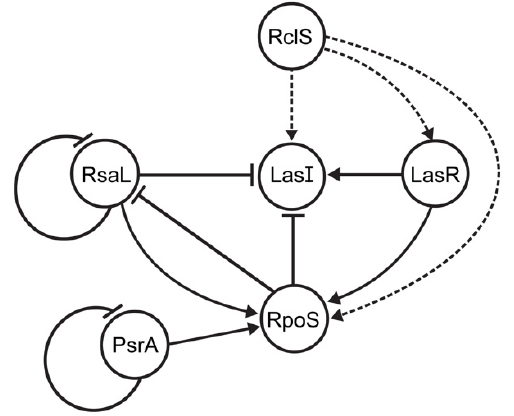
Figure 8. Improved interconnection model of P. capeferrum WCS358 regulatory systems (RclSAR, LasIR and RpoS) in stationary growth phase (improvement of model proposed by Bertani and Ven- turi (2004) [16], adapted with permission). Triggering of signal transduction pathway starting with RclS activation leads to increased expression of the lasI , lasR (this study) and rpoS genes [7]. Gene regulation network between RpoS, LasIR (PpuIR), RsaL and PsrA proteins were described in previ- ous study [16]. Dashed lines indicate indirect gene regulation by RclS sensor kinase. 4. Materials and Methods 4.1. Bacterial Strains and Chemicals Strains P. capeferrum WCS358 (formerly P. putida WCS358) wild type and P. capefer- rum WCS358 Δ rclS mutant with inactivated gene encoding RclS sensor kinase [7] were used in this study. Biosensor strain P . putida F117 was used for AHL detection [41]. AHLs N -3-oxodecanoyl-L-homoserine lactone (3-oxo-C10-HSL) and N -3-oxododecanoyl-L-ho- moserine lactone (3-oxo-C12-HSL) were purchased from Sigma-Aldrich. AHL stock solu- tions (0.5 mM) were prepared in dimethyl sulfoxide (DMSO) and stored at − 20 °C for bi- ological assays. 4.2. RNA Extraction and Sequencing P. capeferrum WCS358 wild type and Δ rclS mutant were incubated in cation-adjusted Mueller Hinton (caMH) medium at 30 °C with aeration until reaching OD 600 value of 1 and 2 (Plate Reader Infinite 200 pro, MTX Lab Systems, Midland, ON, Canada). RNA ex- traction from collected bacterial cells was performed using RNeasy Mini Kit (Qiagen, Hil- den, Germany), with a modified lysis step [42]. AmbionDNAfree Kit (Thermo Fisher Sci- entific, Waltham, MA, USA) was used for DNase I treatment. The total RNA concentration and purity was determined with NanoPhotometer spectrophotometer (IMPLEN, Mün- chen, Germany), while RNA integrity was confirmed using Agilent 2100 Bioanalyzer (Ag- ilent Technologies, Santa Clara, CA, USA). After cDNA library construction, the sequenc- ing was performed using Illumina platform. The cDNA library preparation and RNA-seq was carried out by Novogene Bioinformatics Technology Co., Ltd., Beijing, China. 4.3. Data Analysis The raw reads were filtered to remove low quality reads and reads containing adapt- ers and poly-N sequences. Further, the clean reads were used for calculating Q20, Q30 and GC content. Moreover, clean reads were aligned to genome of P. capeferrum WCS358 strain that was used for RNA isolation in this work (JAKNRD000000000) by Bowtie2 [43]. HTseq was applied to count the number of reads mapped to each gene and FPKM (Frag- ments PerKilobase of transcript sequence per Millions base pairs sequenced) value of each gene was determined based on the length of the gene and sequencing depth. For co-